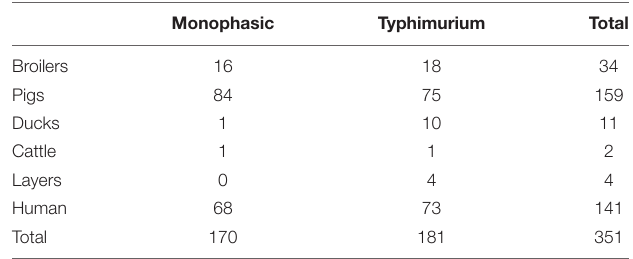
TABLE 2 | Data set composition according to primary source and serovar.